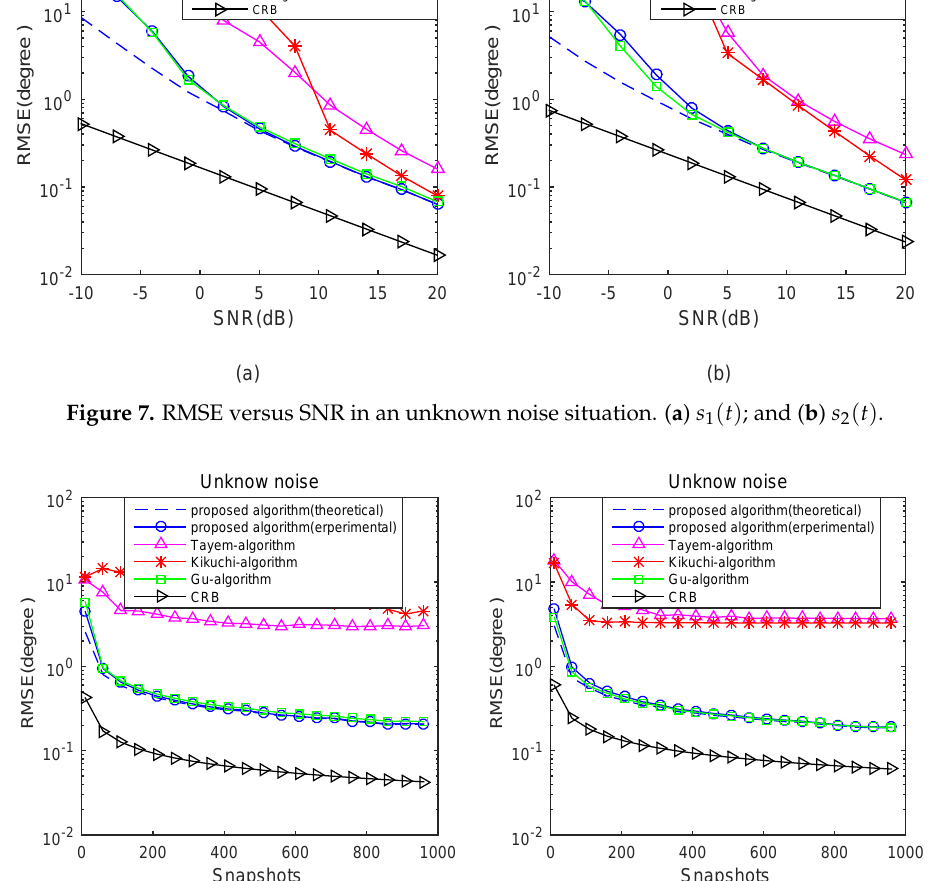
proposed algorithm(theoretical) proposed algorithm(erperimental) Tayem-algorithm Kikuchi-algorithm Gu-algorithm CRB